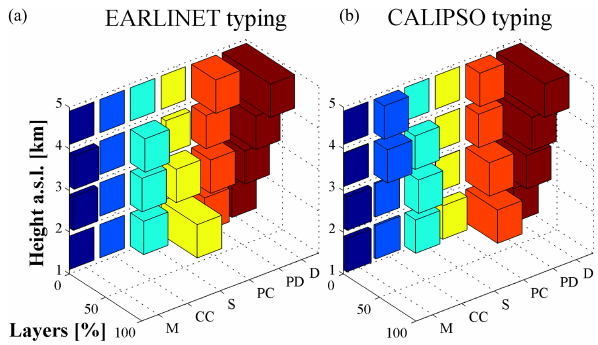
Figure 9. Naples: (a) EARLINET and (b) CALIPSO typing bar plots for 1km range increment. M stands for marine, D for dust, PC for polluted continental, CC for clean continental, PD for polluted dust, and S for smoke subtype.